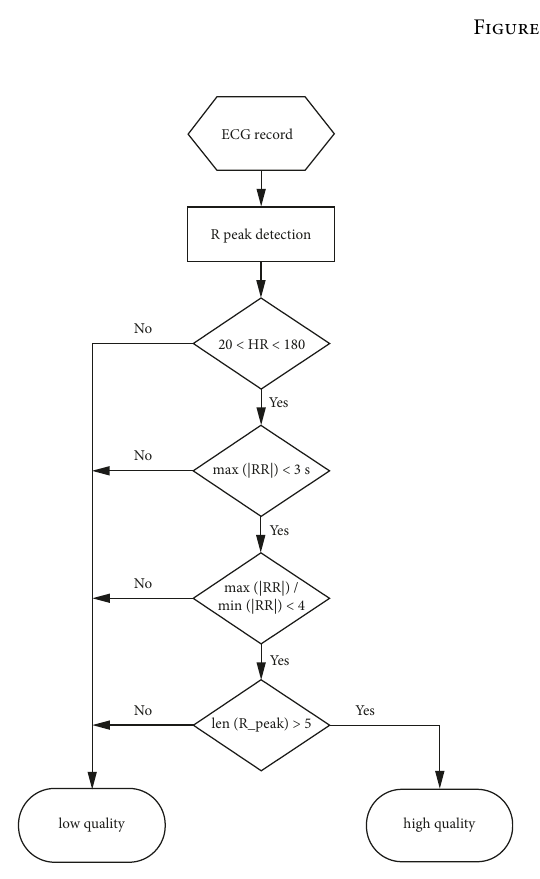
Figure 3: Record quality